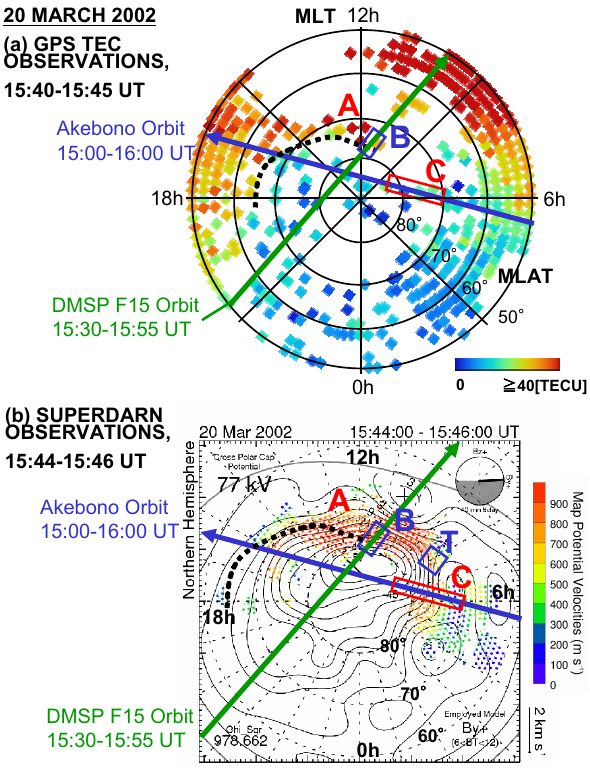
Fig. 3. (a) A map of Total Electron Content (TEC) at 15:40– 15:45UT on 20 March 2002 derived from observations from ground GPS receiver network. The black square dots in the afternoon sec- tor denote the contour of > 30TEC units (TECU) and the extent of the plume toward the cusp; the corresponding contour in the morn- ing sector is not available due to lack of data. Label “A”: region of SED in the GPS-TEC observations; “B”: anti-sunward convection region identified by DMSP F15; “C”: high plasma density region identified by Akebono; “T”: see Sect. 3. (b) A convection map at 15:44–15:46UT on 20 March 2002 derived from SuperDARN radar observations.